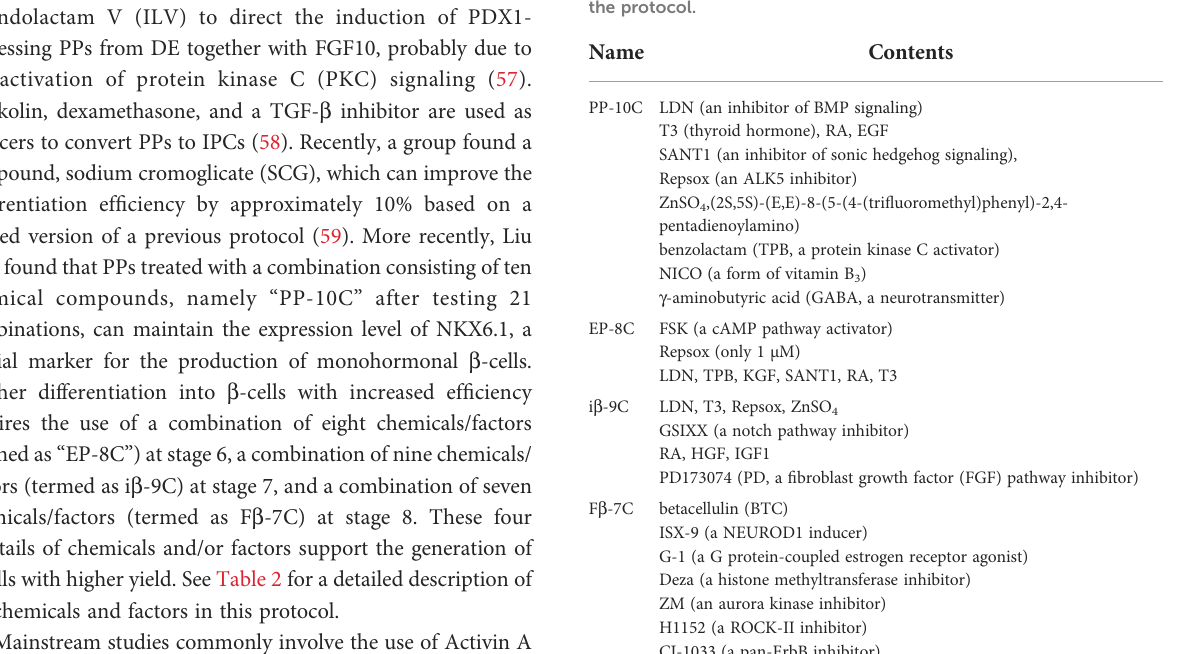
TABLE 2 A detailed description of the chemicals and factors in the